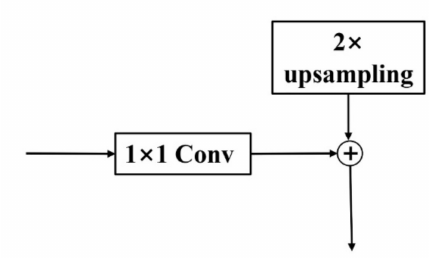
Figure 7. Feature fusion